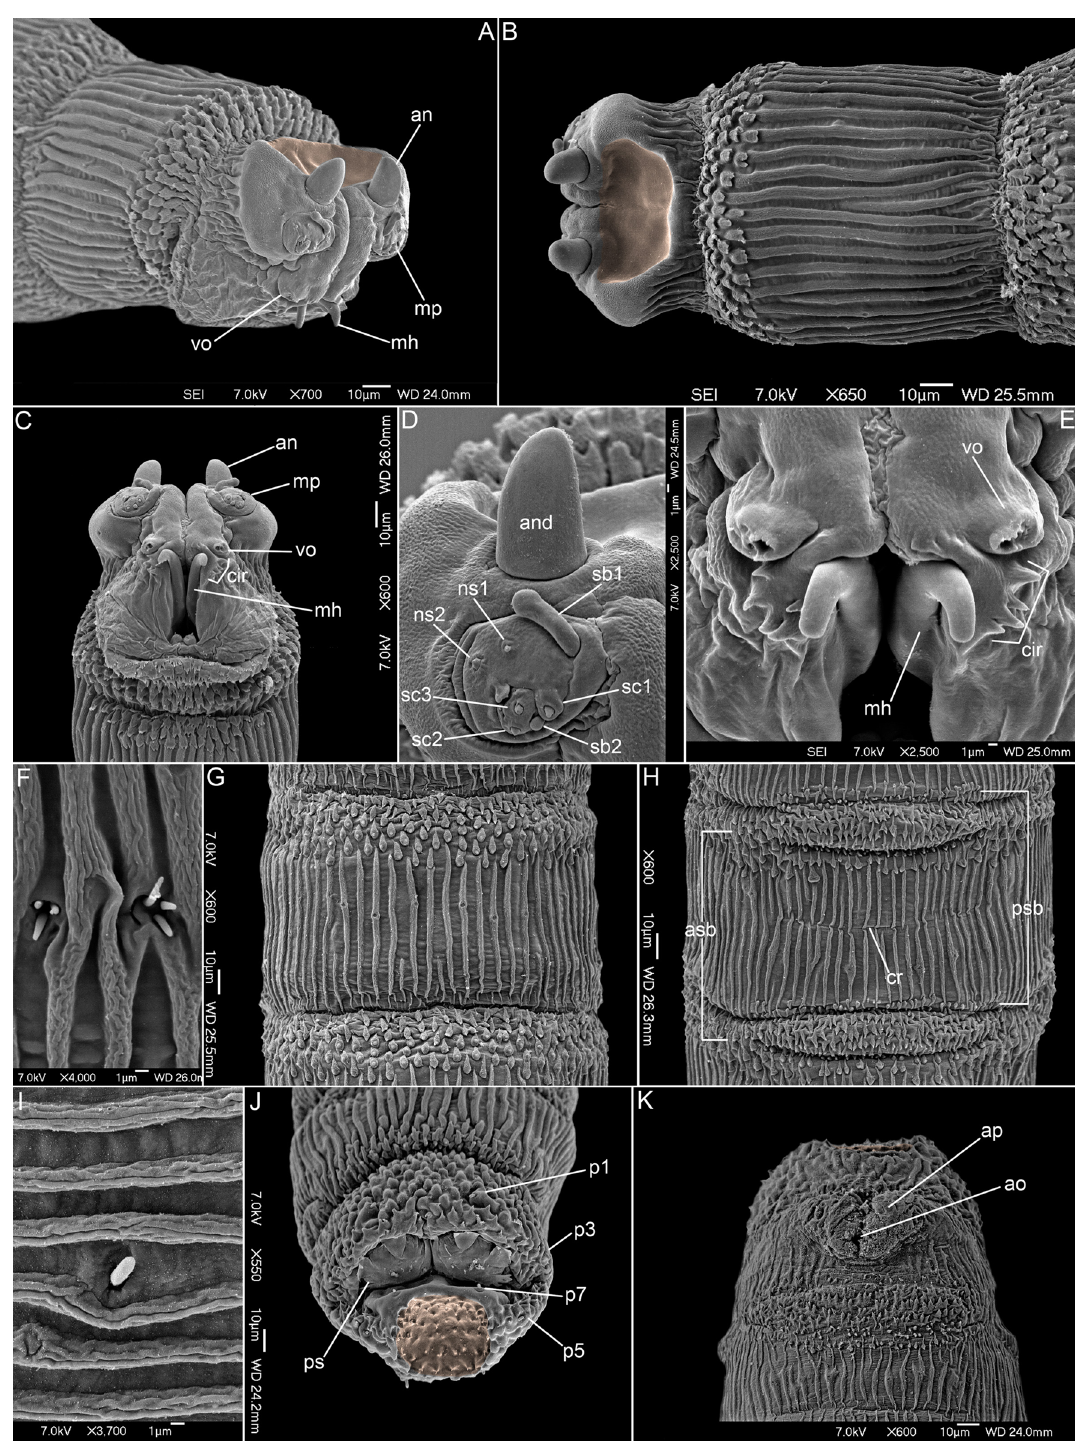
Figure 4. First instar larva of Protomiltogramma plebeia . ( A ) Anterior end, antero-lateral view. ( B ) Anterior end, dorsal view. ( C ) Anterior end, ventral view. ( D ) Antennal complex and maxillary palpus. ( E ) Mouth opening. ( F ) First thoracic segment, Keilin’s organ. ( G ) Second abdominal segment, dorsal view. ( H ) Second abdominal segment, ventral view. ( I ) Third abdominal segment, lateral papilla. ( J ) Posterior end, postero-dorsal view. ( K ) Posterior end, ventral view. Circular depression on pseudocephalon and anal division is highlighted in brown. an, antennal complex; and, antennal dome; ao, anal opening; ap, anal papilla; asb, anterior spinose band; cir, cirri; cr, transverse crevice; mh, mouthhook; mp, maxillary palpus; ns1, first additional sensillum coeloconicum; ns2, second additional sensillum coeloconicum; p1–p7, papillae around spiracular field; ps, posterior spiracle; psb, posterior spinose band; sb1–3, sensilla basiconica 1–3; sc1–3, sensilla coeloconica 1–3; vo, ventral